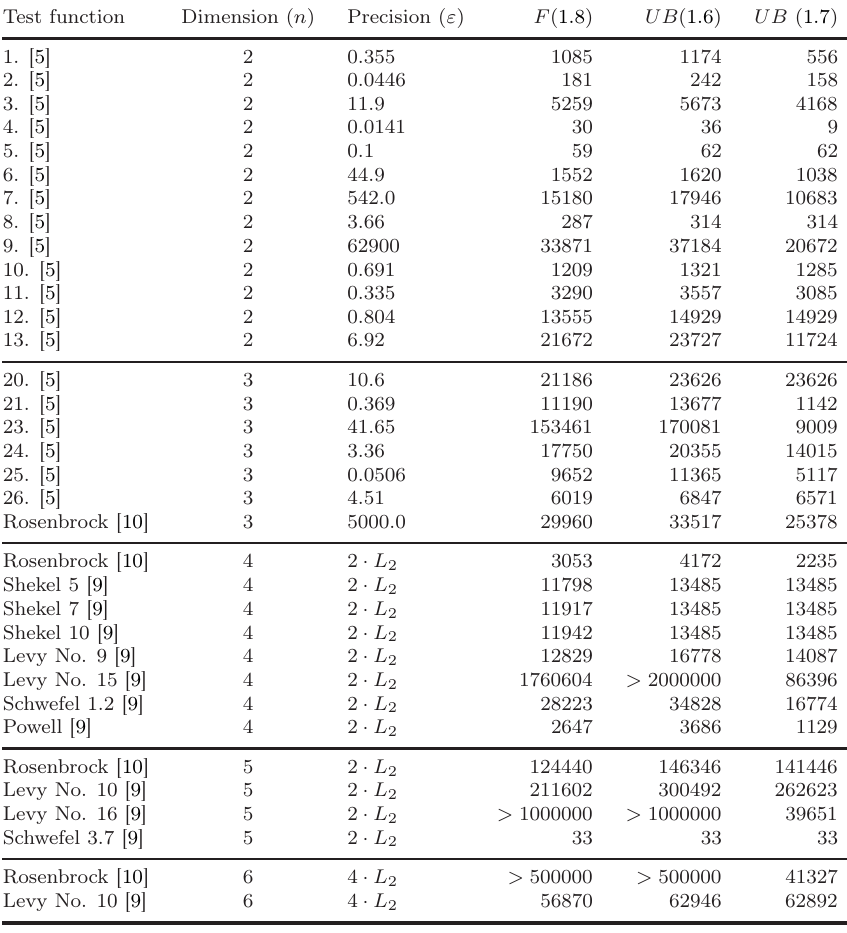
Table 1. Numbers of function